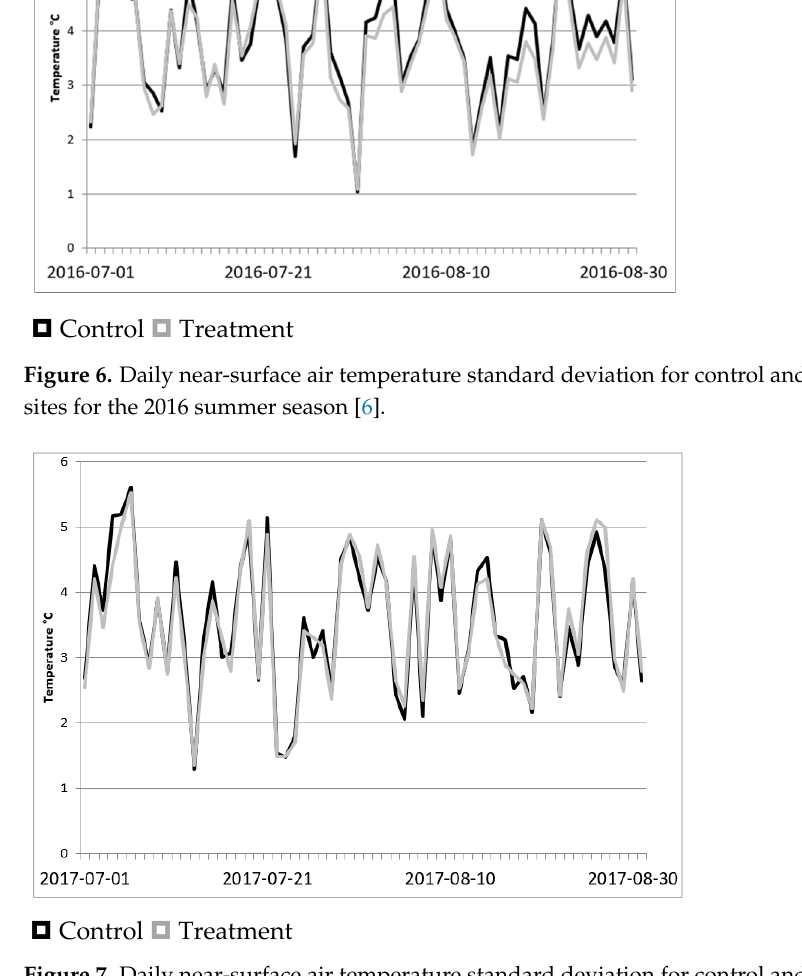
Figure 7. Daily near-surface air temperature standard deviation for control and treatment across all sites for the 2017 summer season [6] .